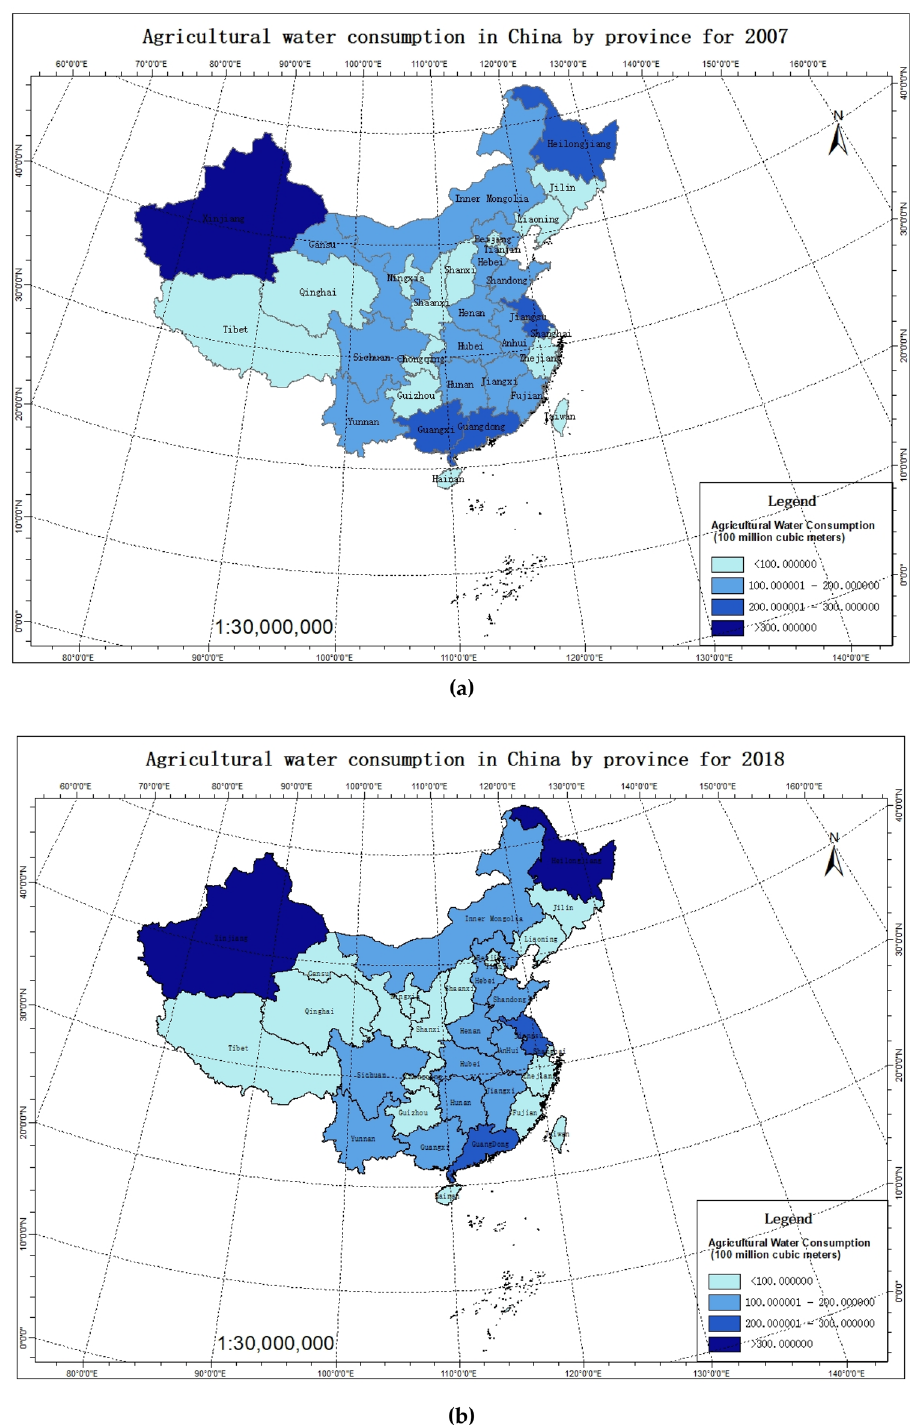
Figure 1. Agricultural water consumption in China by province for (a) 2007 and (b) 2018. Note: Map created using ArcGIS [10.2], (http:// www. esri. com/ softw are/